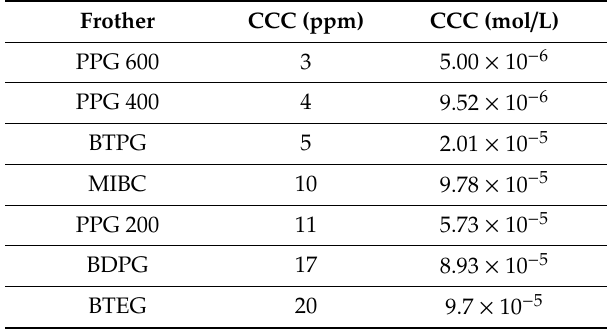
Table 2. CCC values of the frothers investigated in this